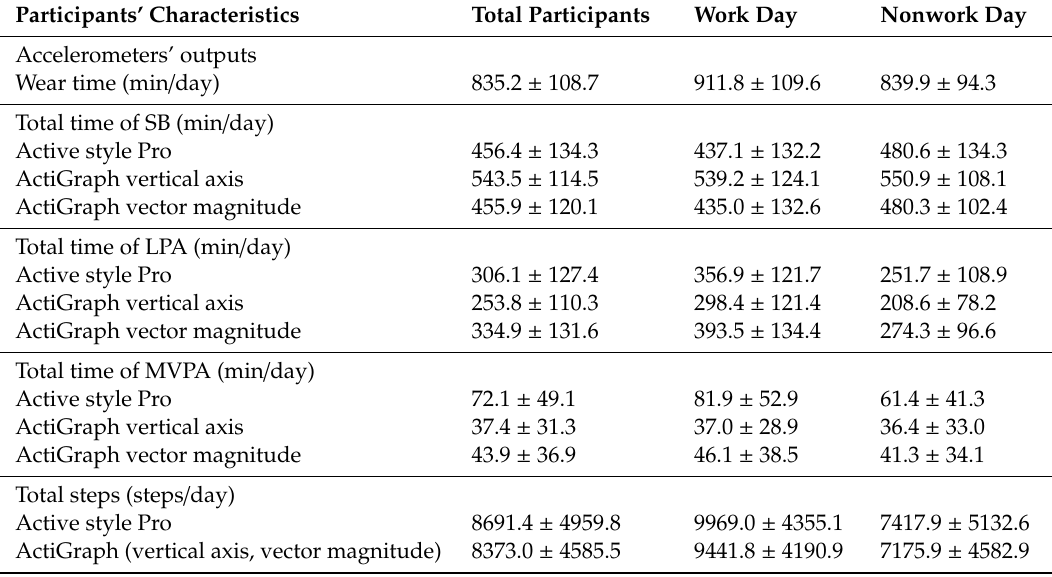
Table 1. Participants’